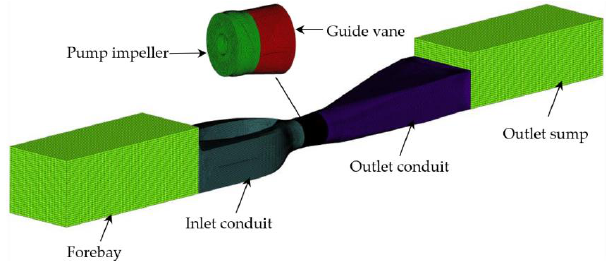
Figure 6. Computational domain and mesh generation of the shaft tubular pump device. Table 2. Grid numbers of each calculation